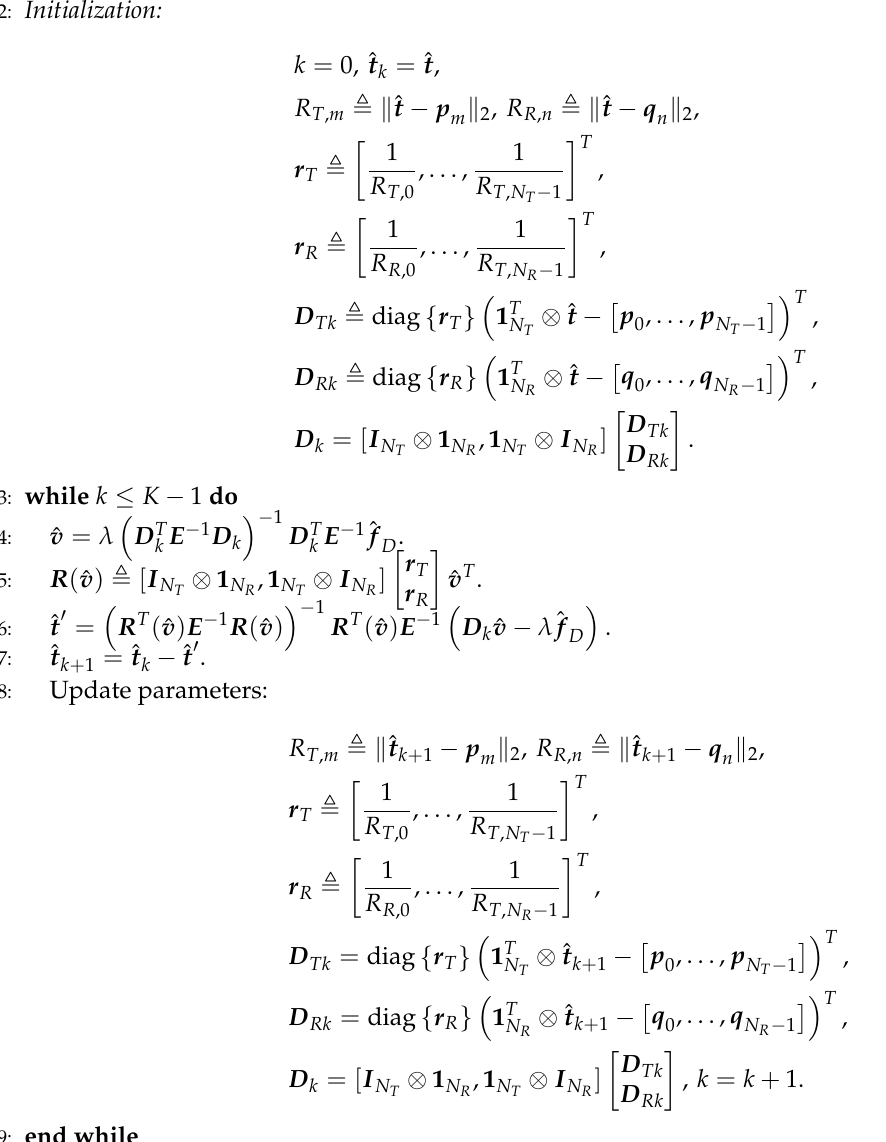
Algorithm 1 Proposed Algorithm for Estimating Target